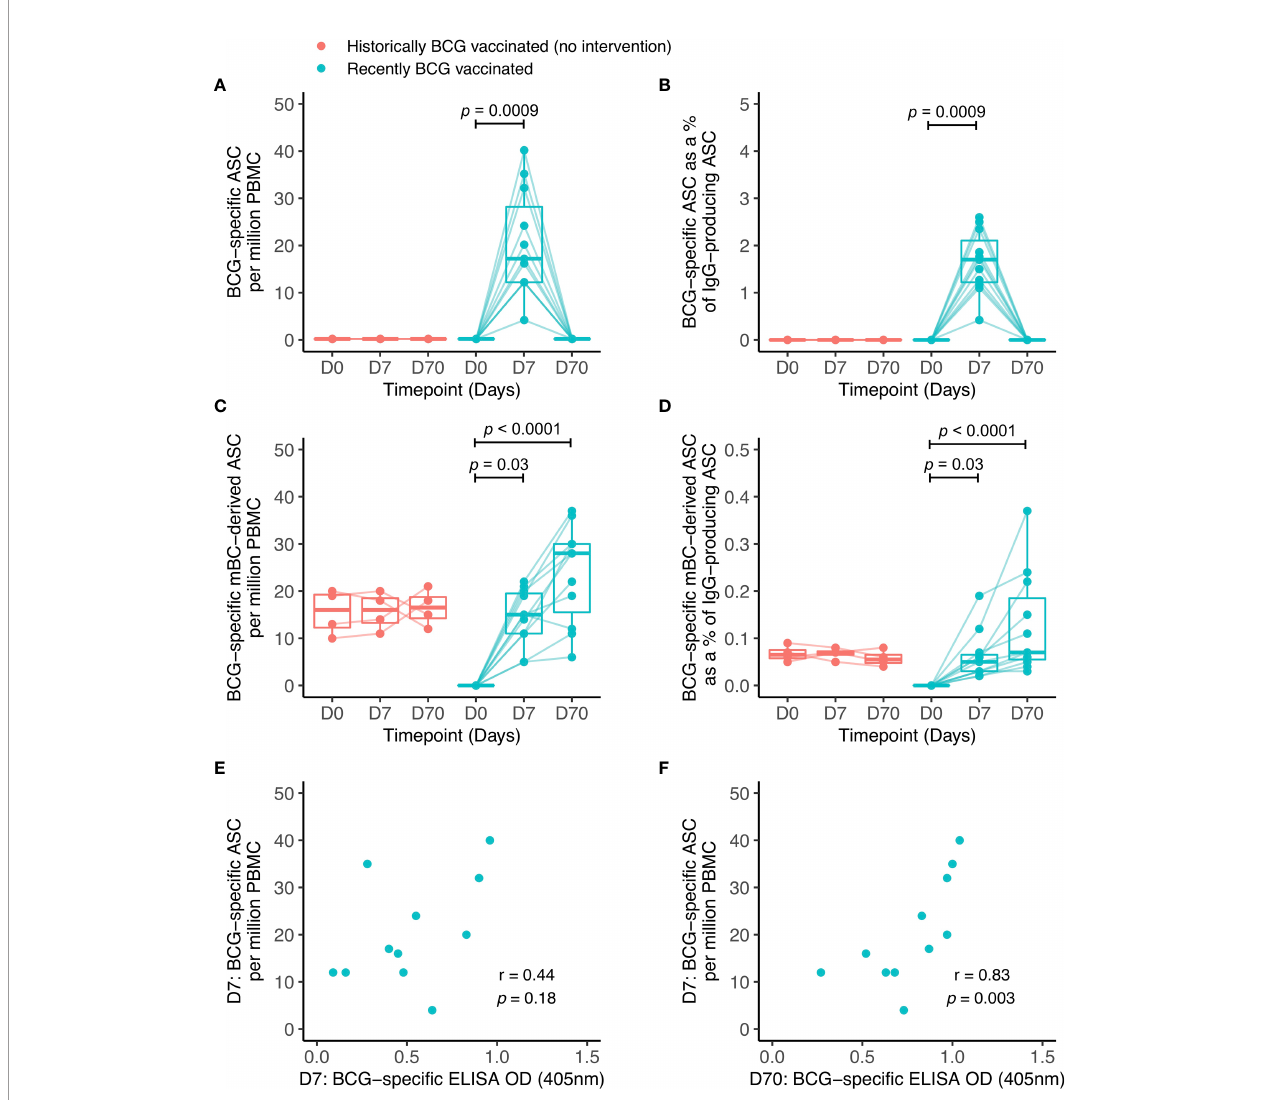
FIGURE 3 | BCG-speci fi c IgG-secreting plasmablast (ASC) and memory B cell-derived ASC responses following BCG vaccination. ASC and mBC-derived ASC responses were determined at baseline, 7 days and 70 days using cells collected from Nepalese military recruits enrolled into human Study 2 (red = historically BCG- vaccinated individuals who received no intervention, cyan = BCG-naïve individuals who received BCG vaccination). ASC responses are presented as the number of BCG-speci fi c ASCs per million PBMC (A) and as the proportion (%) of total IgG-secreting ASC (B) . mBC responses are shown as the number of BCG-speci fi c mBC-derived ASC per million cultured PBMC (C) and as the proportion (%) of mBC-derived ASC of total IgG-secreting ASC (D) . Points represent the mean of triplicate values, boxes indicate the median value with the interquartile range (IQR) and the upper whisker extends to the largest value no further than 1.5 * IQR from the hinge, the lower whisker extends from the hinge to the smallest value at most 1.5 * IQR from the hinge. Outliers are plotted individually. A Friedman test with Dunn ’ s multiple comparisons test was used (A – D) . A Spearman rank correlation was performed between ASC responses and BCG-speci fi c IgG responses measured at 7 days (E) and 70 days (F) after BCG